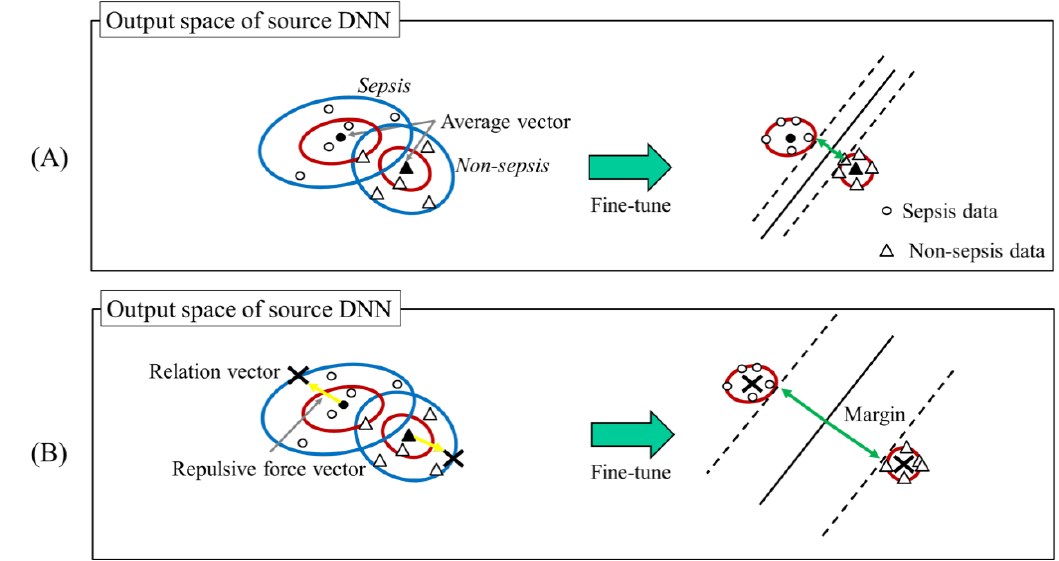
Figure 2. Relationship between relation vectors and hyperplane. ( A ): The margin using the average vector as the relation vector, and ( B ) represents the margin using our method.